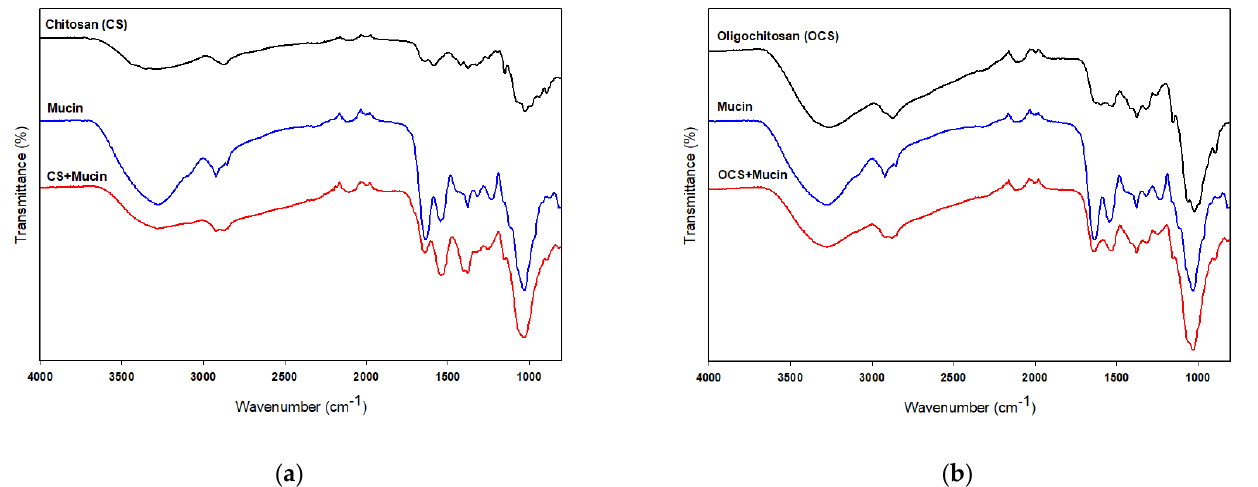
Figure 6. FT-IR spectra of CS, mucin, and CS + mucin ( a ) and OCS, mucin, and OCS + mucin ( b ).